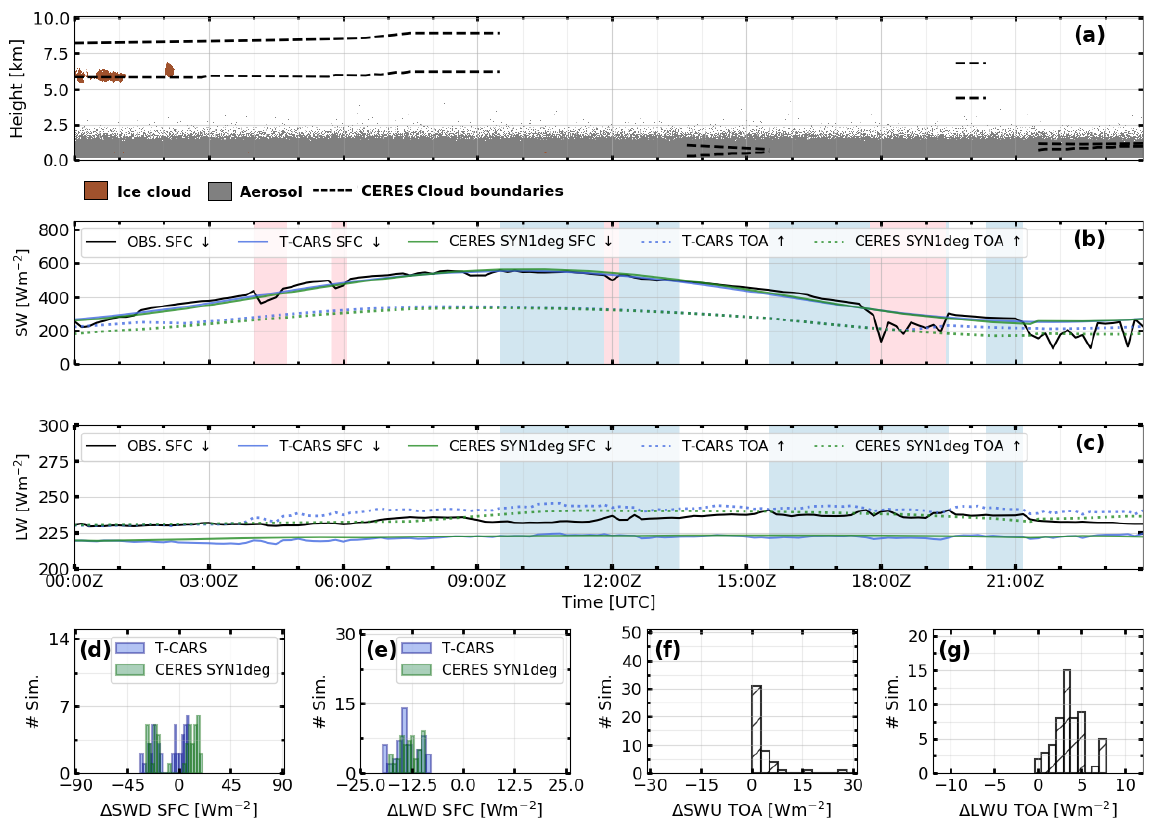
Figure 7. Overview of radiative fluxes for the 3 July 2017 case. Panel (a) shows the time series of the Cloudnet target classification and the CERES SYN1deg-based cloud boundaries (dashed black lines). Panel (b) and (c) show the time series of the SW fluxes and LW fluxes, re- spectively. In both panels ( b and c ), the down-looking arrow indicates ( ↓ ) the downward fluxes at the surface (SFC), and the up-looking arrow ( ↑ ) shows the upward fluxes at the top of the atmosphere (TOA). Panels (d) and (e) show histograms of the difference of T-CARS/CERES SYN1deg SWD and LWD fluxes and observations at the SFC, respectively. Panels (f) and (g) show histograms of the difference of T-CARS minus CERES SYN1deg SWU and LWU fluxes at the TOA, respectively. Pink shading indicates periods when the ship’s superstructures obstructed the shipborne flux observations. Light-blue background indicates the CS period considered for the analysis.